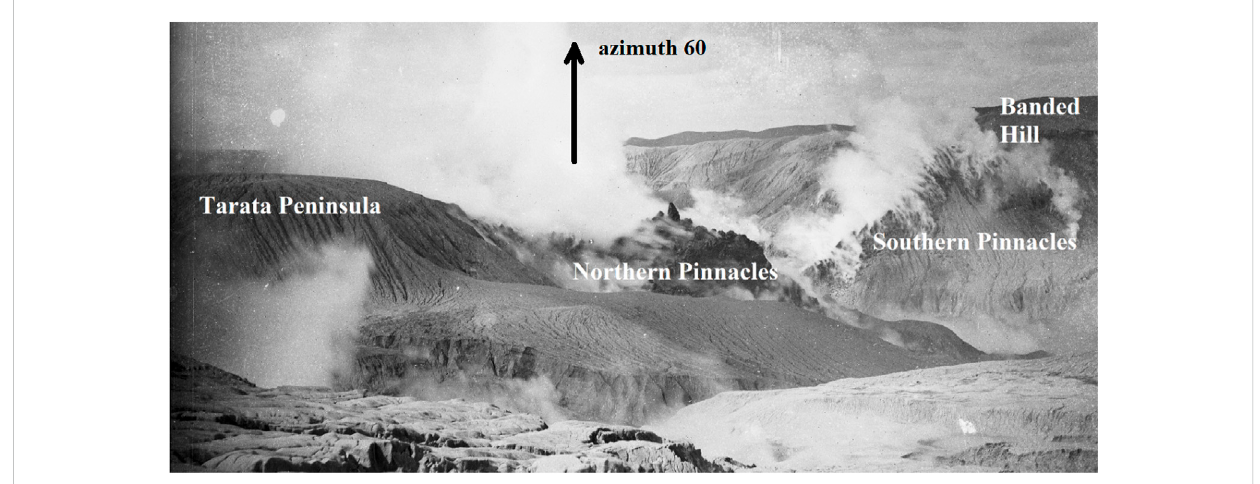
FIGURE 4 Tarata Peninsula abutting thenorthernpinnacles and BandedHillabutting the southern pinnacles (and extending out of theshot). Note theazimuth 60 ° arrow to orient the image (Burton, MA_1323002 Te